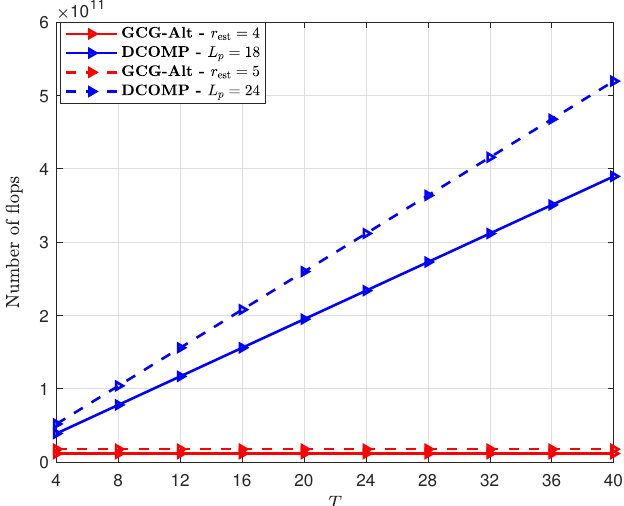
Figure 5. Complexity comparison of the GCG-Alt estimator and the DCOMP estimator under the ULA system, where N t = 64, N r = 16,PNR = 10 dB, and S =